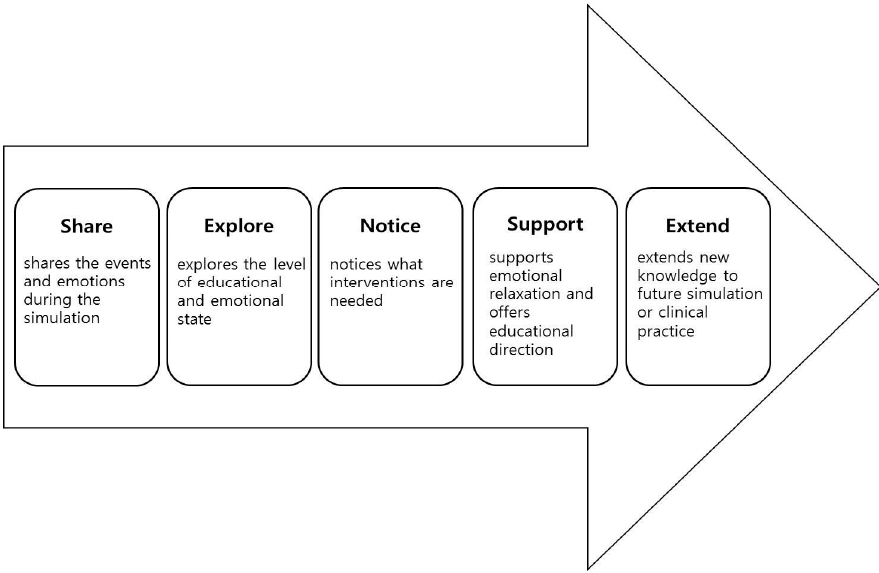
Figure 2. Share–Explore–Notice–Support–Extend (SENSE) model.